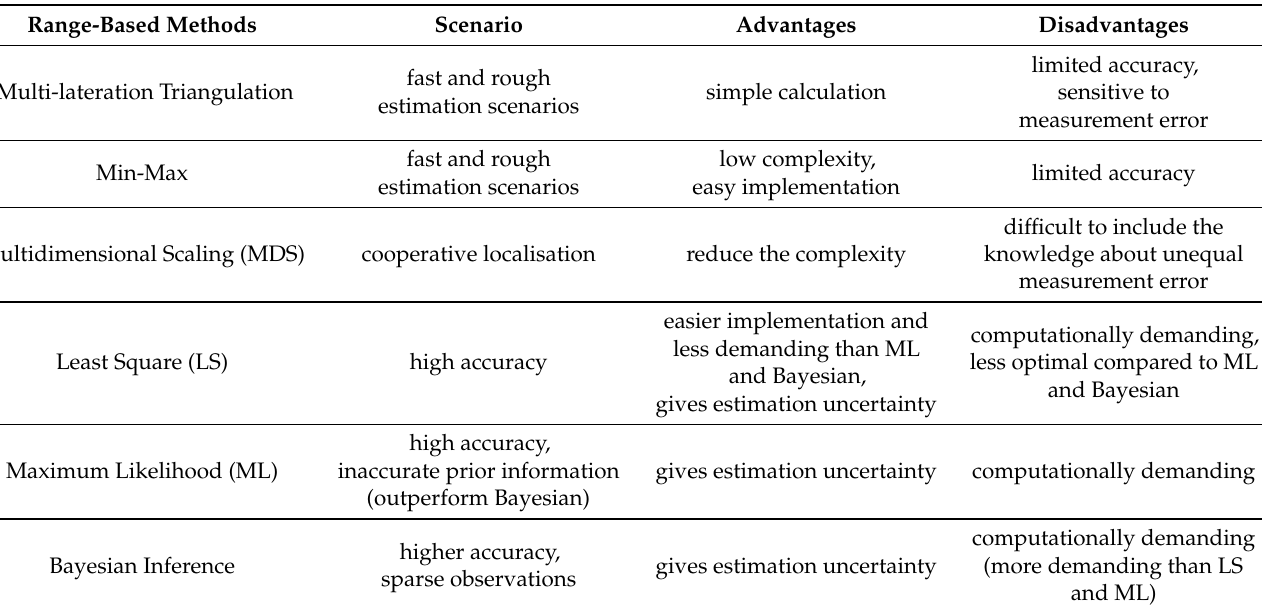
Table 2. Comparison between range-based